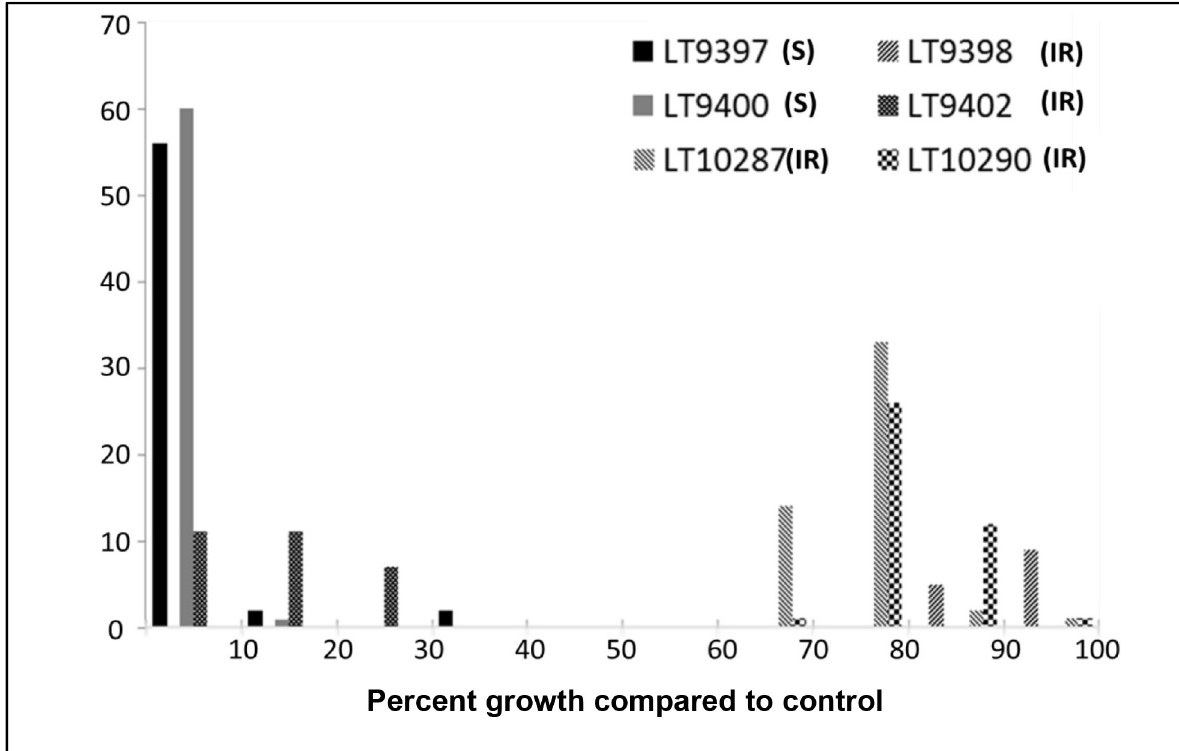
Fig 8. Response of 254 Phytophthora capsici single zoospore progeny from six field isolates to the oomycete-toxic chemical, mefenoxam. The six parental field isolates are listed in the upper right and denoted with various fill patterns. Parental isolates are either sensitive (S) to mefenoxam where their ability to grow on mefenoxam media is low compared to growth on un-amended control media or intermediately resistant (IR) where they can grow at roughly half their normal rate of growth on amended media. The progeny, charted as a histogram, ranges from fully sensitive to fully